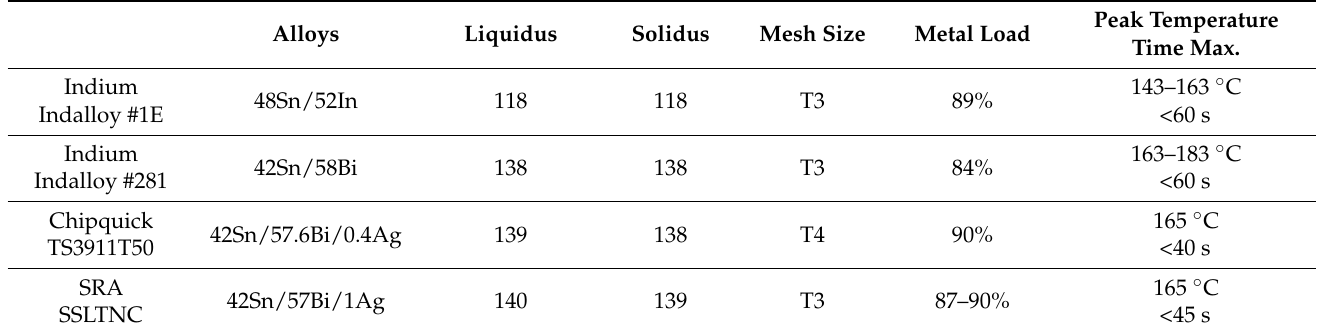
Table 4. Solders used: main characteristics.